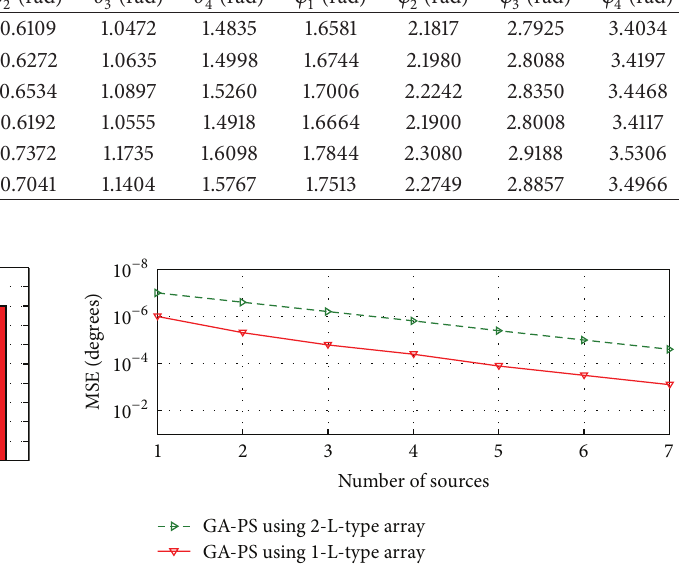
Figure 5: MSE versus number of sources at 10dB